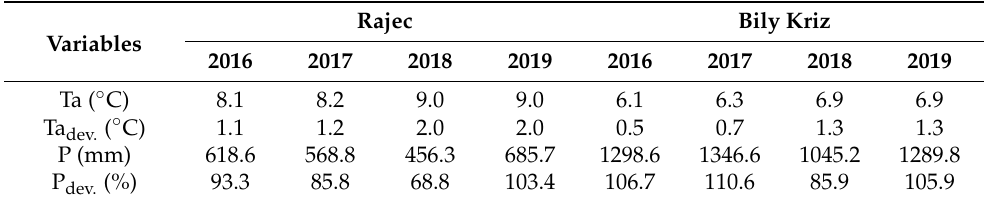
Table 1. The annual average air temperature (Ta) and annual sums of precipitation (P) measured at the ESP Rajec and Bily Kriz in the years 2016–2019. The values below are deviations in ◦ C resp. % according to LTM